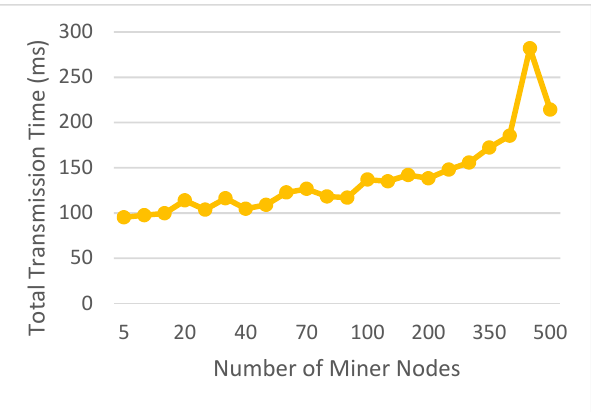
Figure 8. The total transmission time vs. the number of nodes for the PoW model.